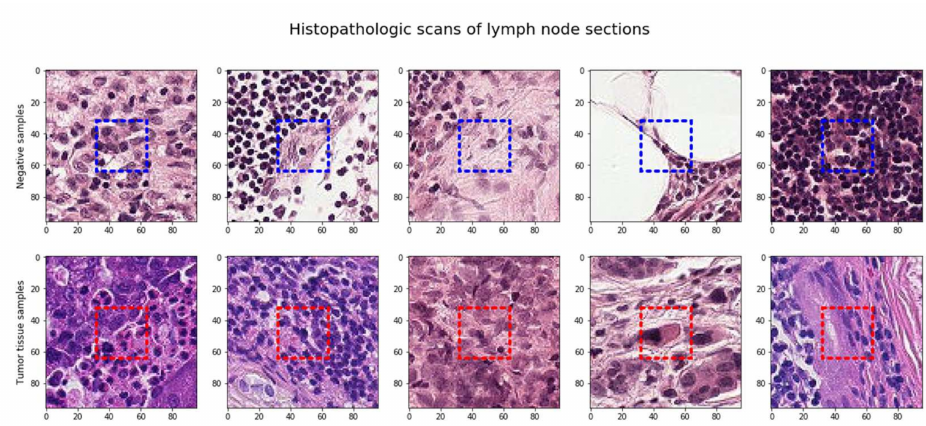
Figure 2. Random sampling of the dataset.